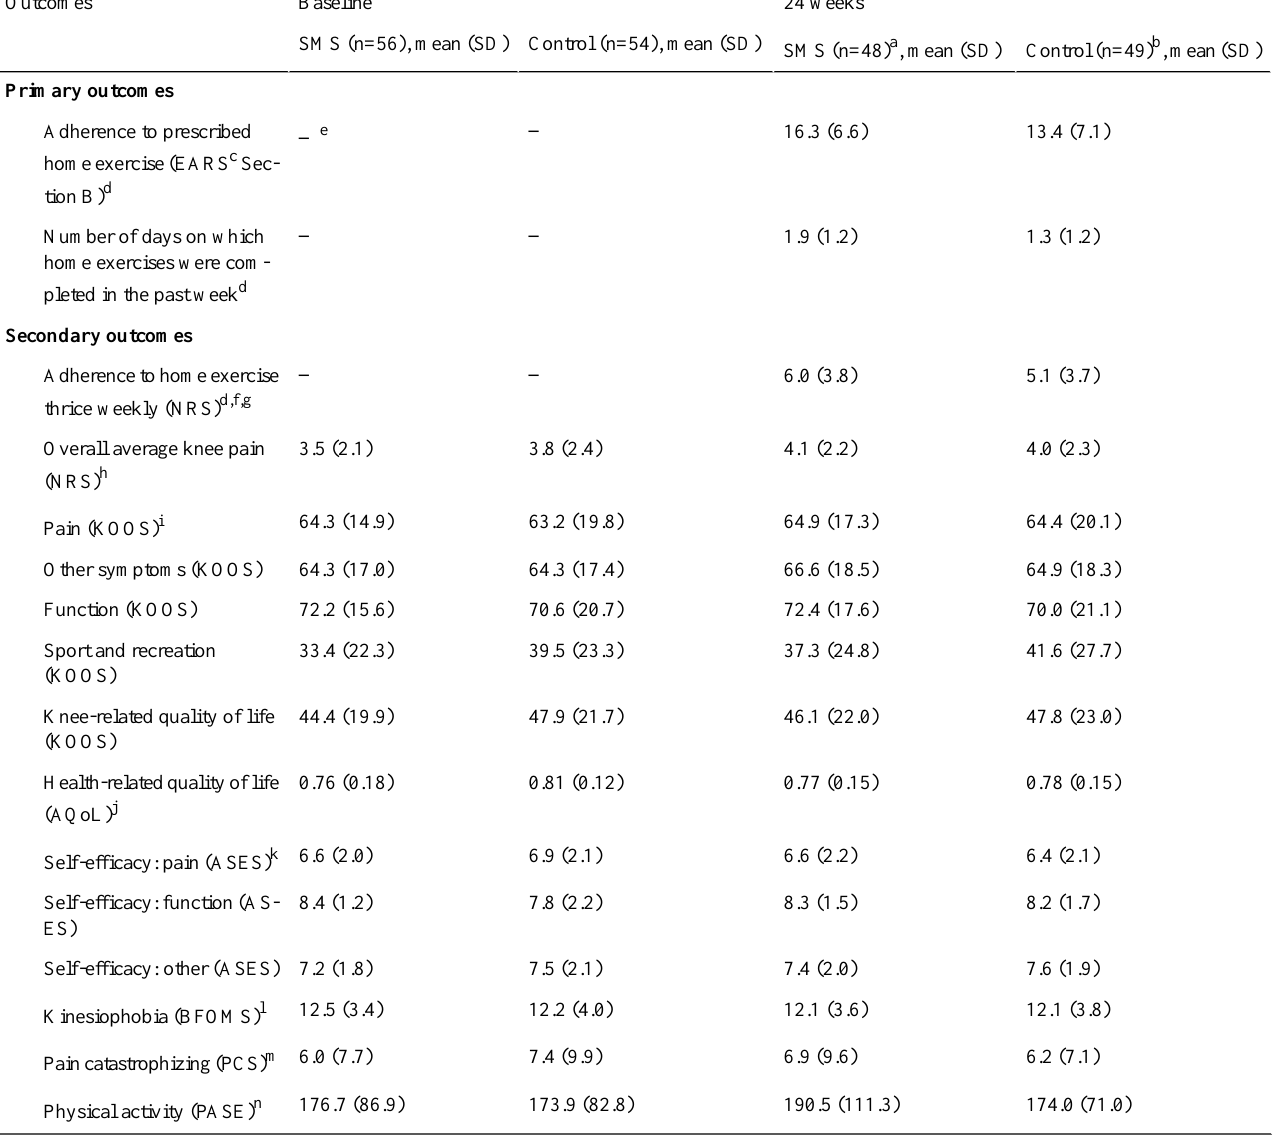
Table 2. Mean (SD) scores on continuous outcome measures across time, by group.